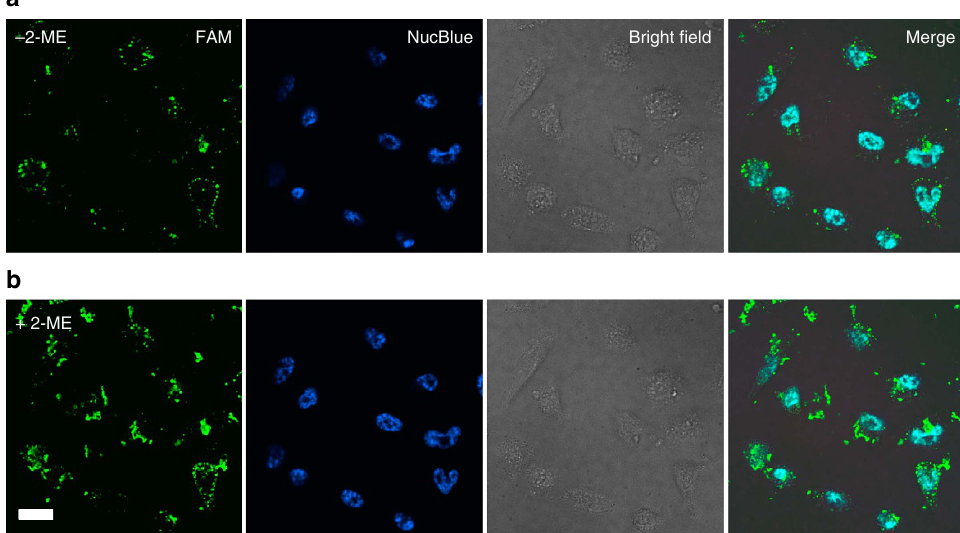
Figure 8 | Images of cells after intracellular operation of the DNAzyme motor and chemical cleavage. ( a ) Images of MDA-MB-231 cancer cells after intracellular operation of the DNAzyme motor for 60min. ( b ) Images of MDA-MB-231 cancer cells after additional treatment with